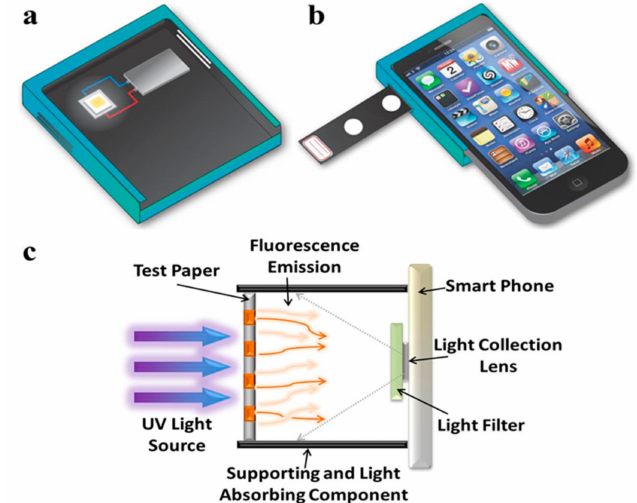
Figure 1. ( a ) A schematic of the desired portable image-recording device, which contains an LED (yellow square in the center of white square), a battery (rectangular with gradient gray), and a plastic shell with two slots on both sides. ( b ) A schematic of the desired portable device combined with a cellphone and a paper stripe. ( c ) A schematic of the basic design components for fluorescence detection, using the camera system of a cellphone.